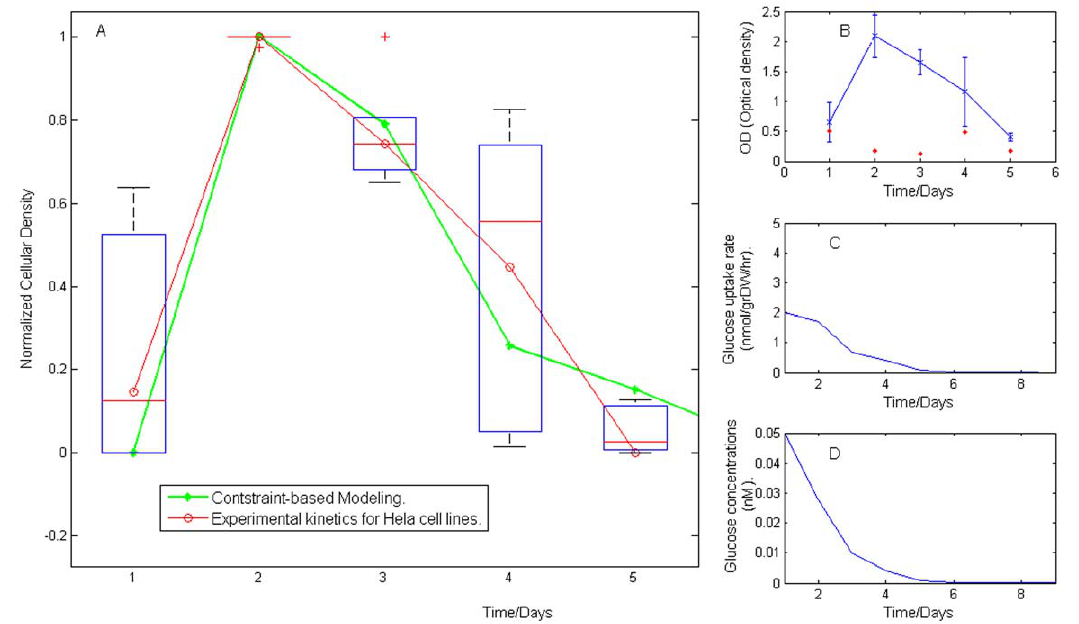
Figure 2. Temporal profile of kinetic cell growth. (A) Comparative analysis between the growth rate obtained experimentally and in silico . (B) Average and standard deviation obtained in the kinetics measurements for Hela cell lines. As described in methods, growth rate was monitored every 24 hours for five days, and six replicates were obtained for each absorbance measurement. Statistical properties characterizing the kinetic growth on Hela cell lines are shown in Figure 2(B) , while the temporal behavior of glucose uptake rate and external concentration predicted by in silico procedures are depicted in (C) and (D) , respectively. Coefficients of variation obtained at each measurement are reported by the red points in (B).